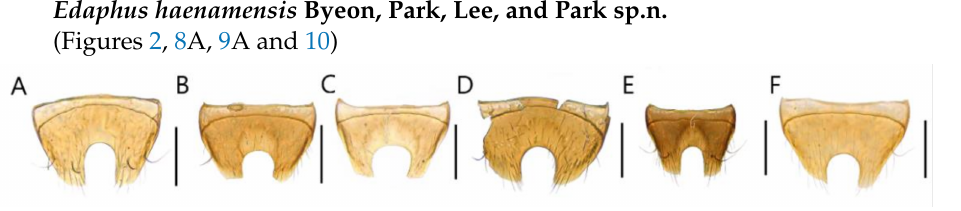
Figure 8. Abdominal sternite VIII of male: ( A ) Edaphus haenamensis sp.n. ; ( B ) E. odaesanensis sp.n. ; (C ) E. suyuensis sp.n. ; (D ) E. ulsanensis sp.n. ; ( E ) E. lederi ; ( F ) E. koreanus . Scale bars: ( A – F ) = 0.1